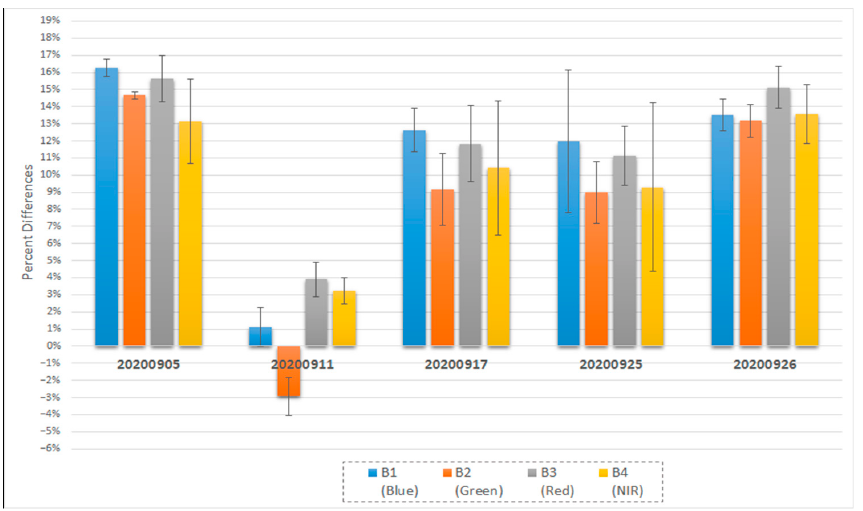
Figure 15. The SkySat radiometric calibration stability (September 2020) given as average results over ROIs.